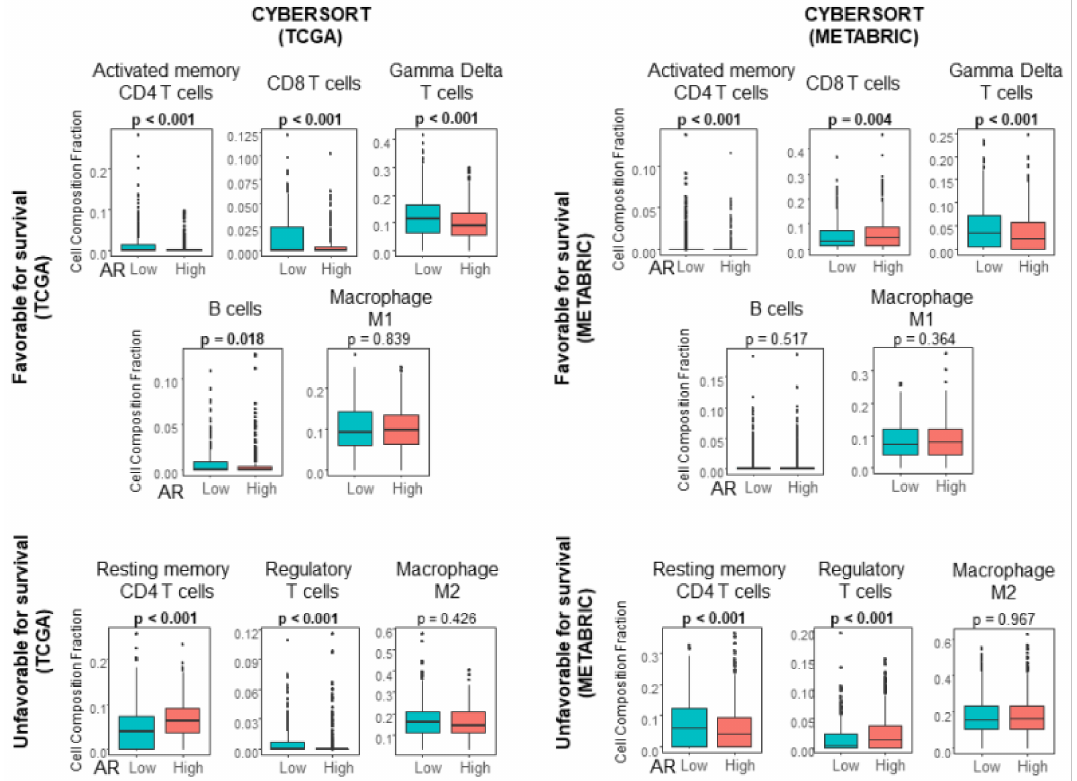
Figure 4. In CIBERSORT analysis, activated memory CD4 T cells and Gamma Delta T cells in AR high tumors are lower than those in AR low tumors in ER-positive